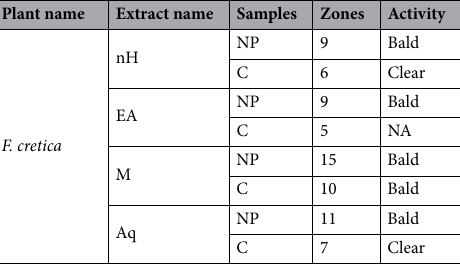
Table 5. Protein kinase inhibition potential of F. cretica crude extracts and its ZnO nanoparticles. * DMSO negative control, Surfactin positive control (20 µg/disc; 16 mm zone – = No activity.